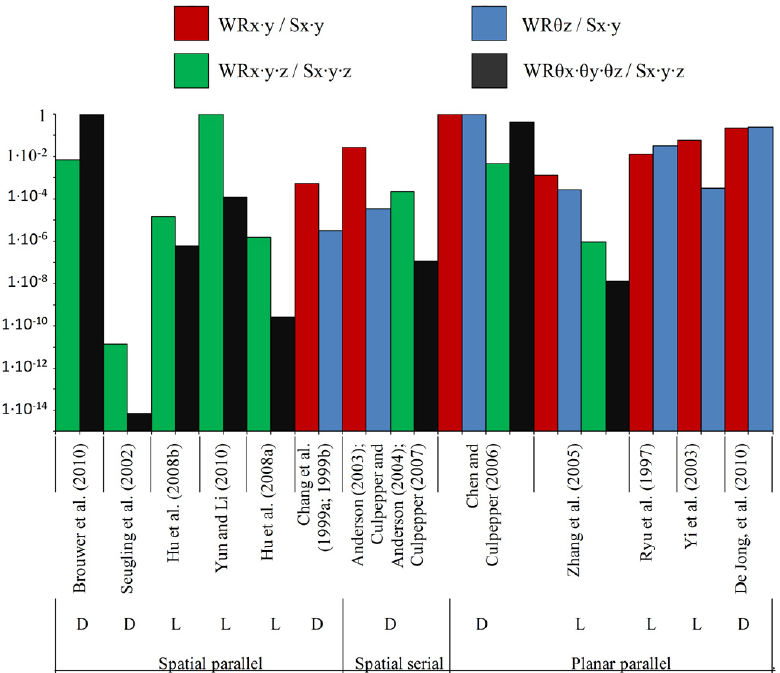
Figure 7. The ratios between translation, or rotation, and size for each compliant stage, if data was available. The ratios were normalized to the largest in the group, shown in logarithmic scale. The mechanisms use distributed compliance (D) or lumped compliance